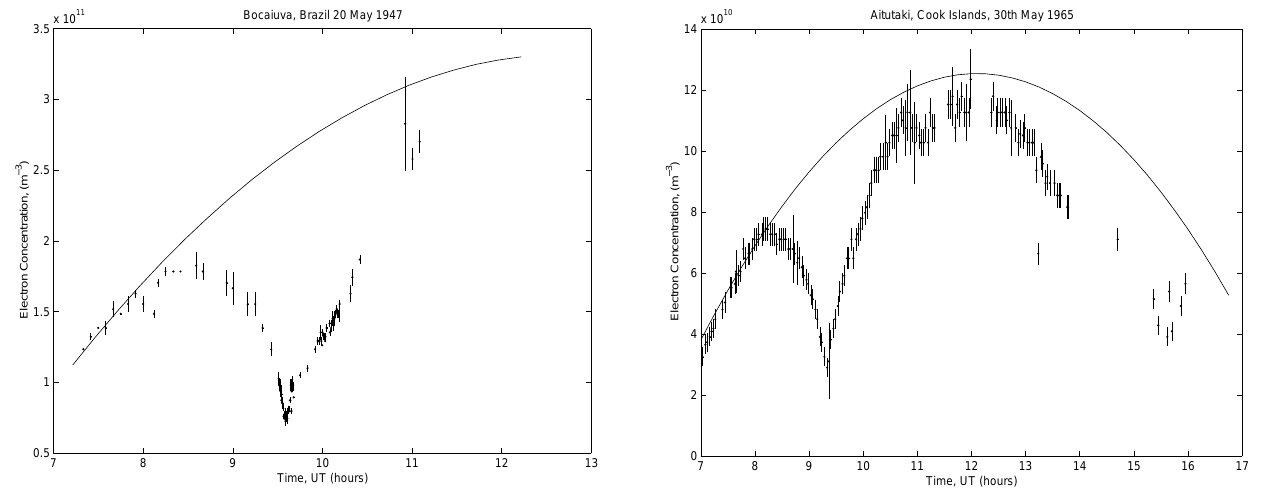
Fig. A1. The variation of the E region peak electron concentration with time during the eclipse of 20 May 1947 at Bocaiuva, Brazil (points). The control day is represented by a polynomial fit to the data from an adjacent day (solid line).